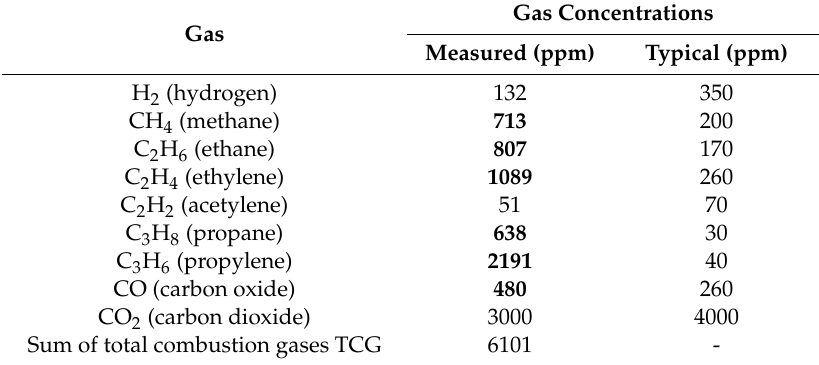
Table 9. The gas concentrations measured for oil samples taken from 10 MVA, 110/6 kV power transformer (exceedance of the typical values is marked in bold font).